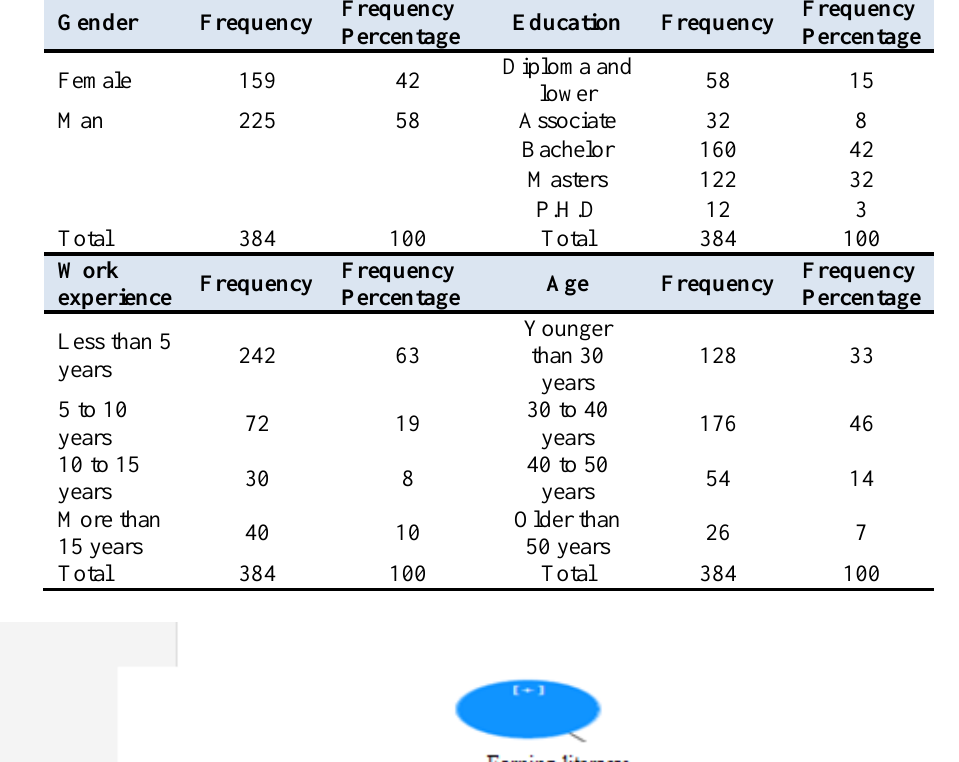
Table 3. The demographic statistics of the research